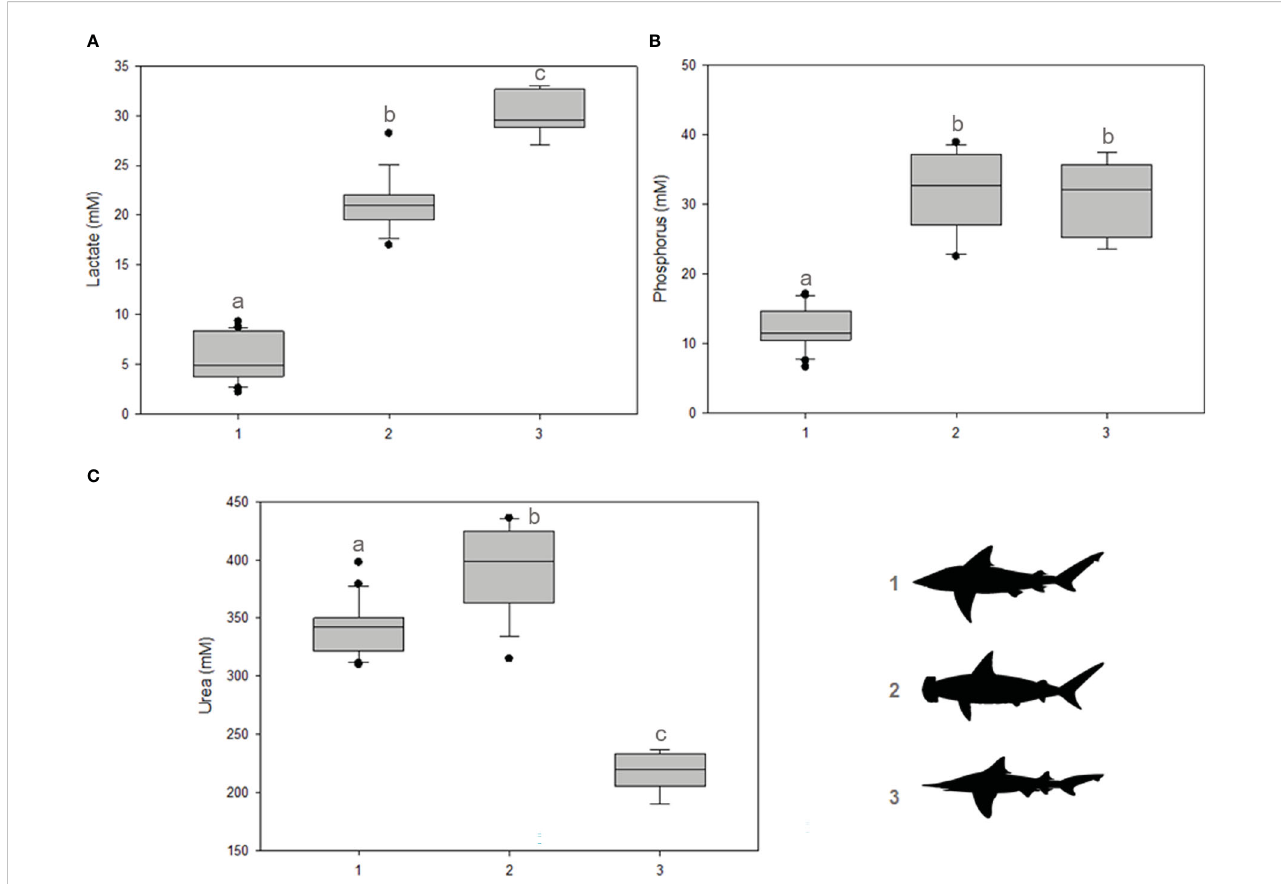
FIGURE 2 Secondary stress markers in shark serum. (A) Lactate concentrations; (B) Phosphorus concentrations; (C) Urea concentrations. The shark groups are indicated in the graph by 1) Carcharhinus spp., 2) Sphyrna spp., and 3) I oxyrhynchus . Statistical differences are represented by lowercase